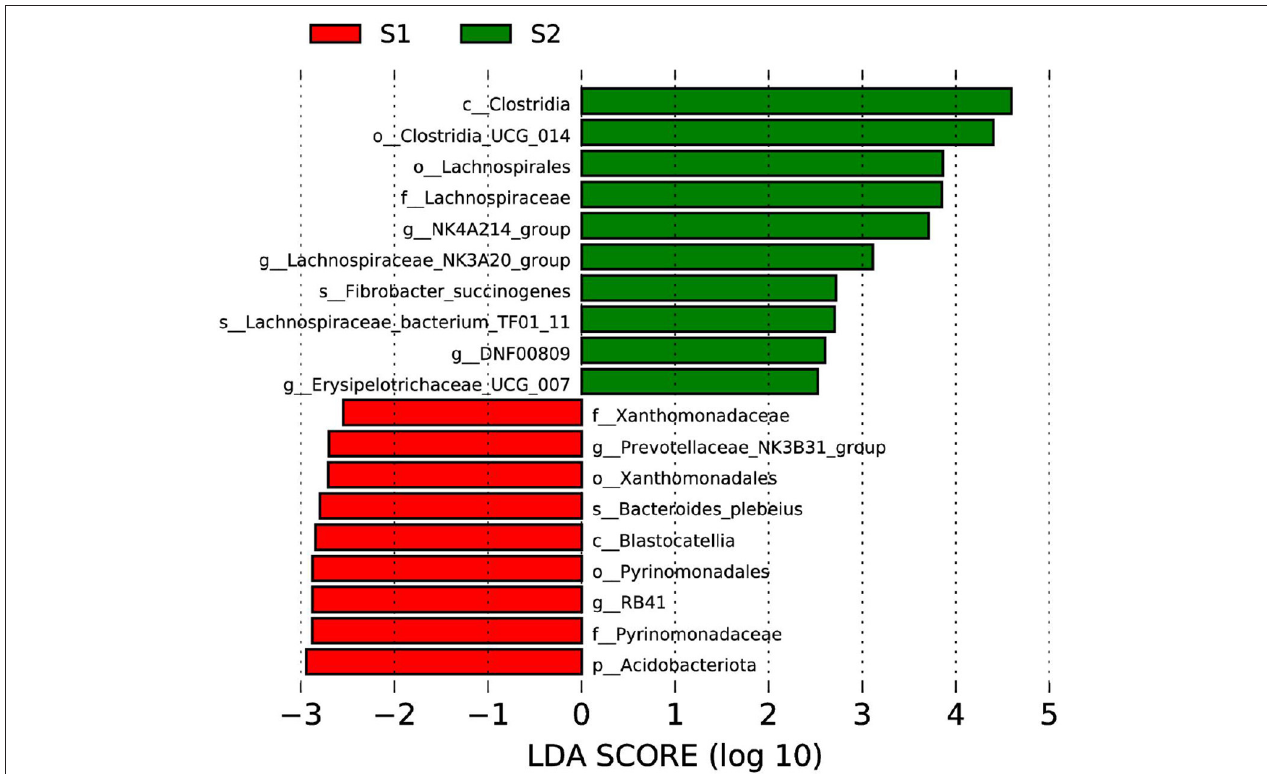
FIGURE 2 | Bacterial taxa differences between control and FWBPs groups. Linear discriminant analysis (LDA) coupled with effect size (LEfSe) analysis was performed to identify the bacterial taxa differentially represented in control and FWBPs groups at different taxonomy levels. S1, the milk replacer ( n = 6); S2, supplemented with 2 ‰ fermented wheat bran polysaccharides in the milk replacer ( n =